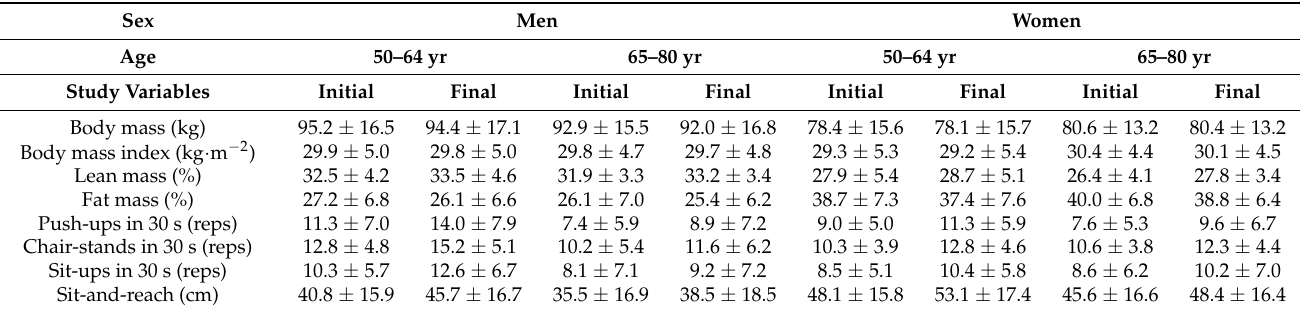
Table 2. Body composition, muscular physical fitness, and flexibility for men and women of different ages before and after the 4-week training